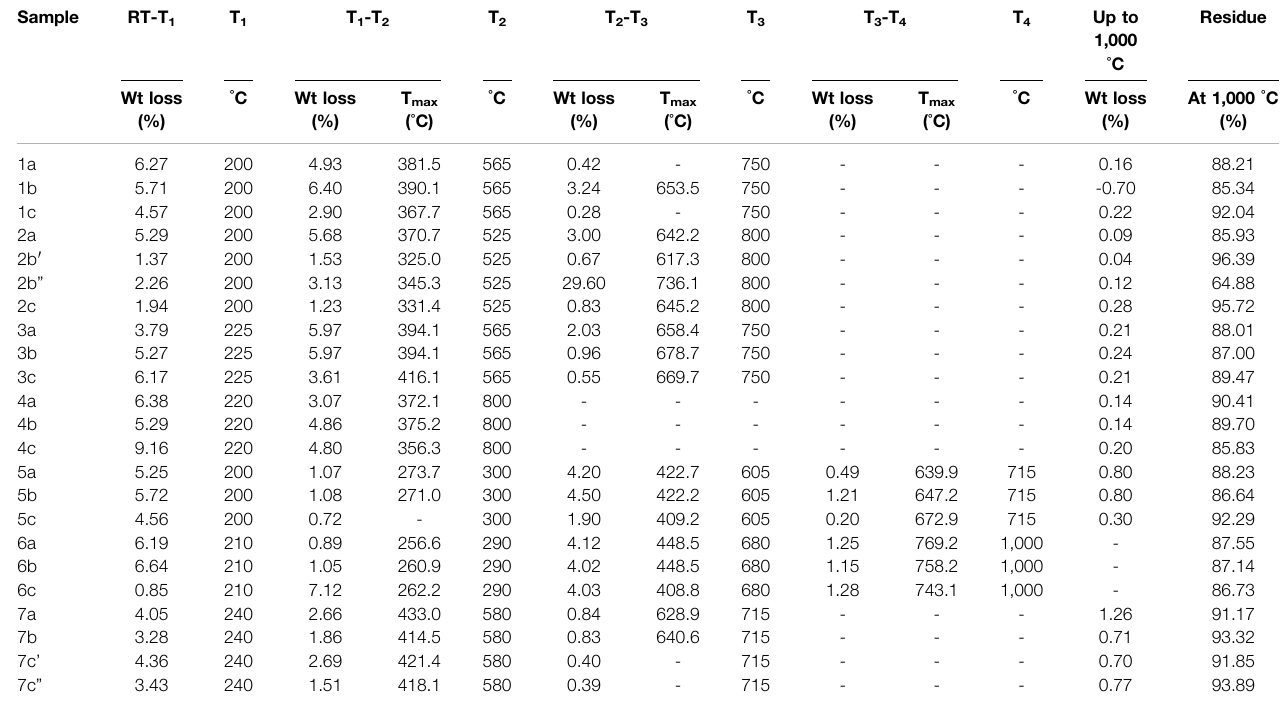
TABLE 4 | Main parameters of the processes as evidenced in TG and DTG curves.